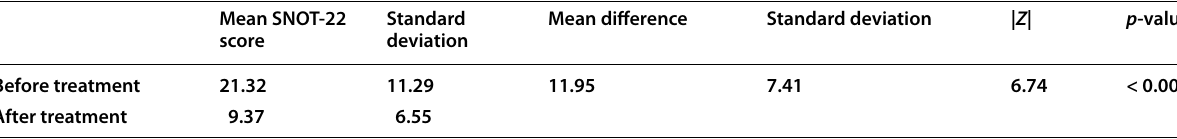
Table 1 Mean SNOT-22 score before and after treatment in group